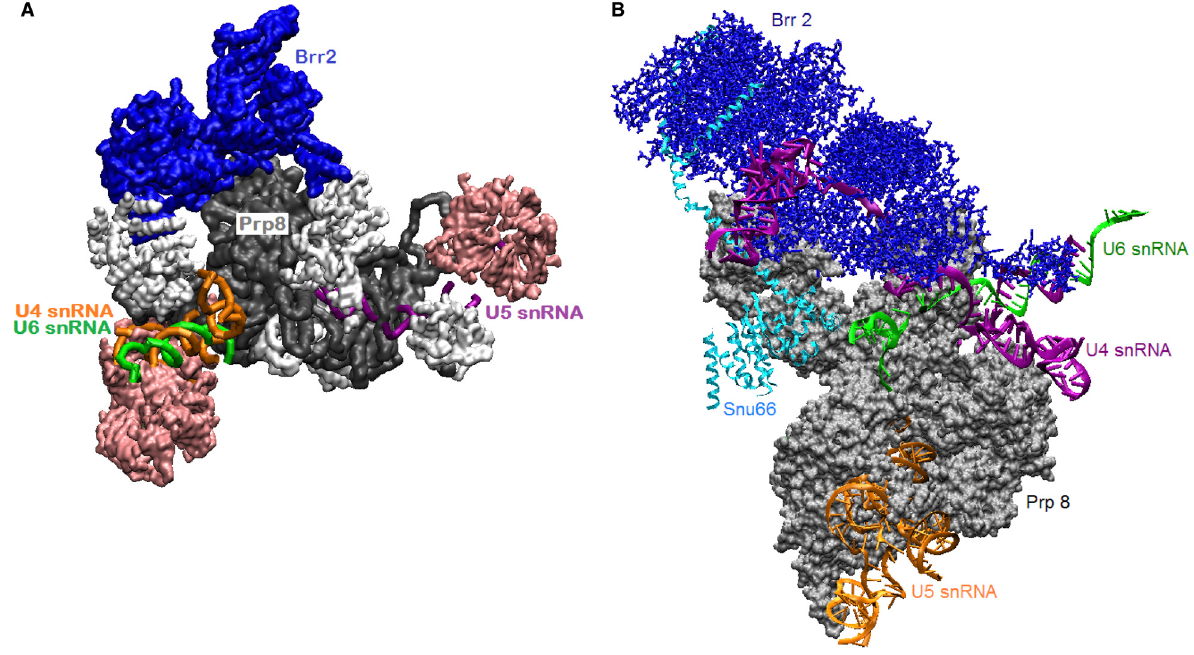
Figure 3. Two tri-small nuclear ribonucleoprotein particle (snRNP) structures trap different states of Brr2. A . Human tri-snRNP cryo-electron microscopy (cryo-EM) at 7 Å resolution 72 shows Brr2 sitting on Prp8 (PDB ID 3jcr). A U4/U6 snRNA duplex is visible. Sm and Lsm rings are pink; other proteins are white. B . In a yeast tri-snRNP complex 70 , (PDB ID 5GAN), U4 snRNA is threaded through Brr2 in the RNA-binding tunnel. These structures might correspond to the tri-snRNP in the nucleus ( A ) and the tri-snRNP poised for activation by Brr2 as it joins the pre-spliceosome ( B ). Visualized with visual molecular dynamics (VMD).